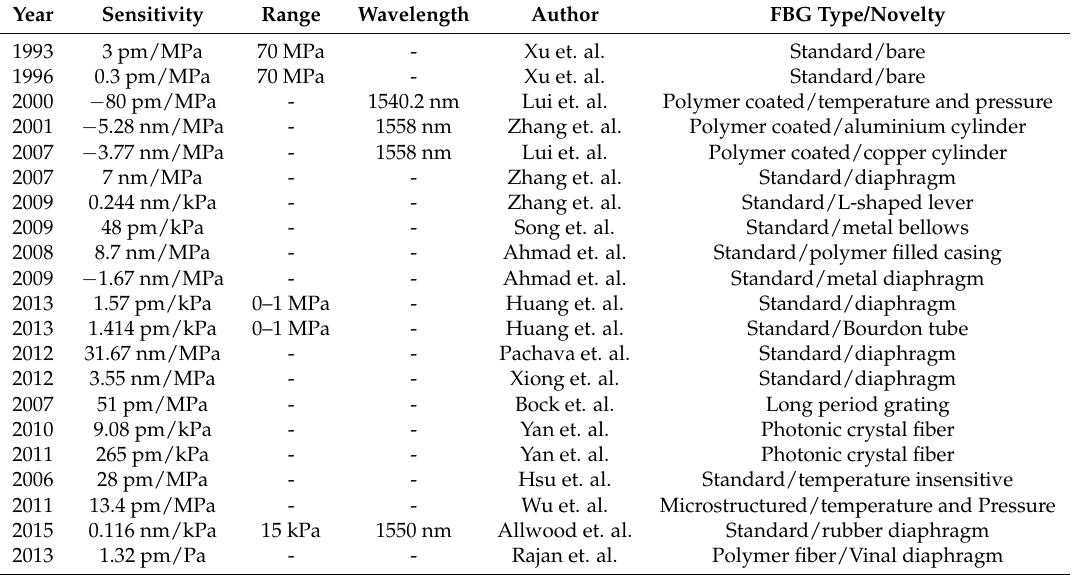
Table 2. Summary of Fiber Bragg Grating Pressure Sensors in Order of